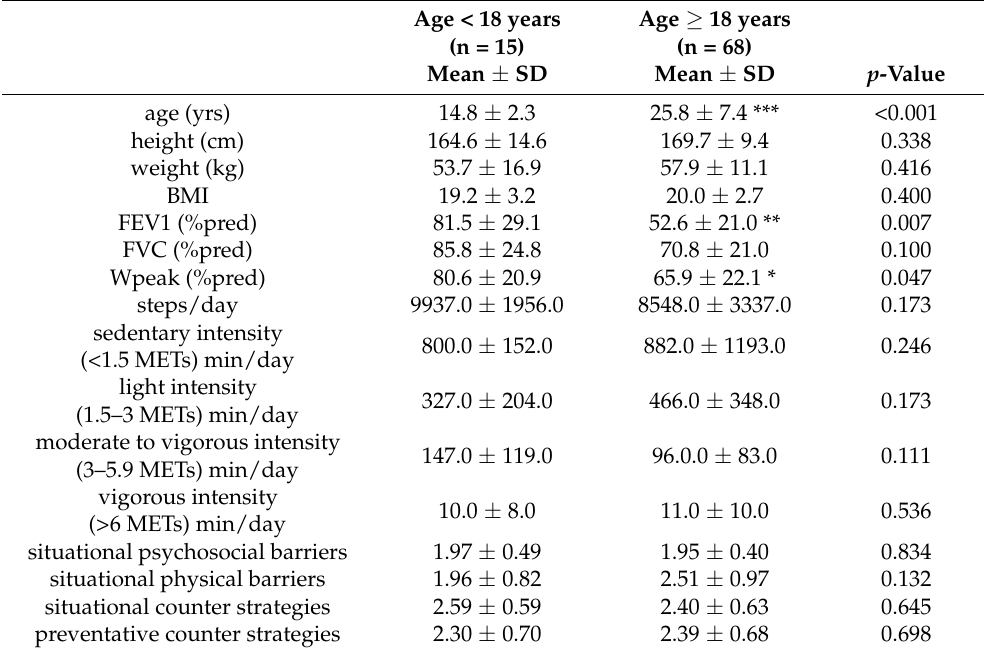
Table 3. Anthropometric characteristics, lung function and steps/day, and intensity of physical exercise of participants by